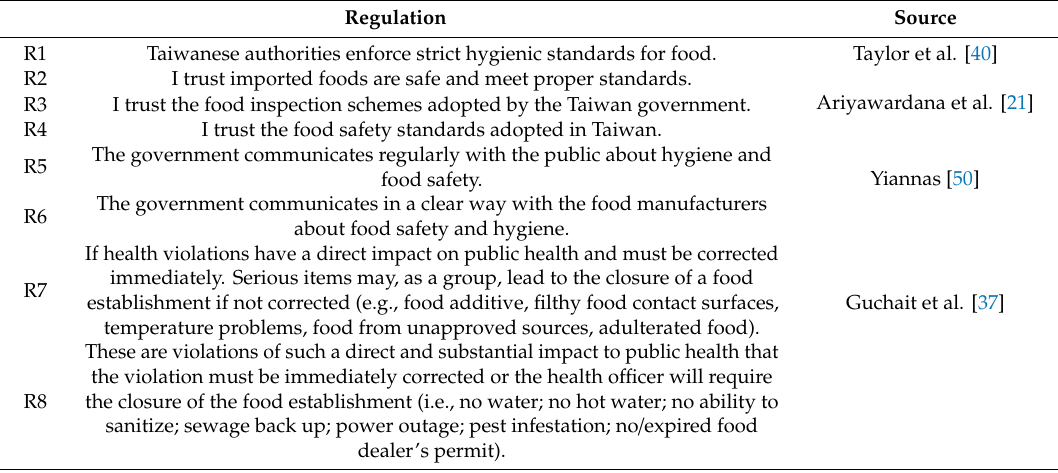
Table 3. Indicators of food safety gap between government and